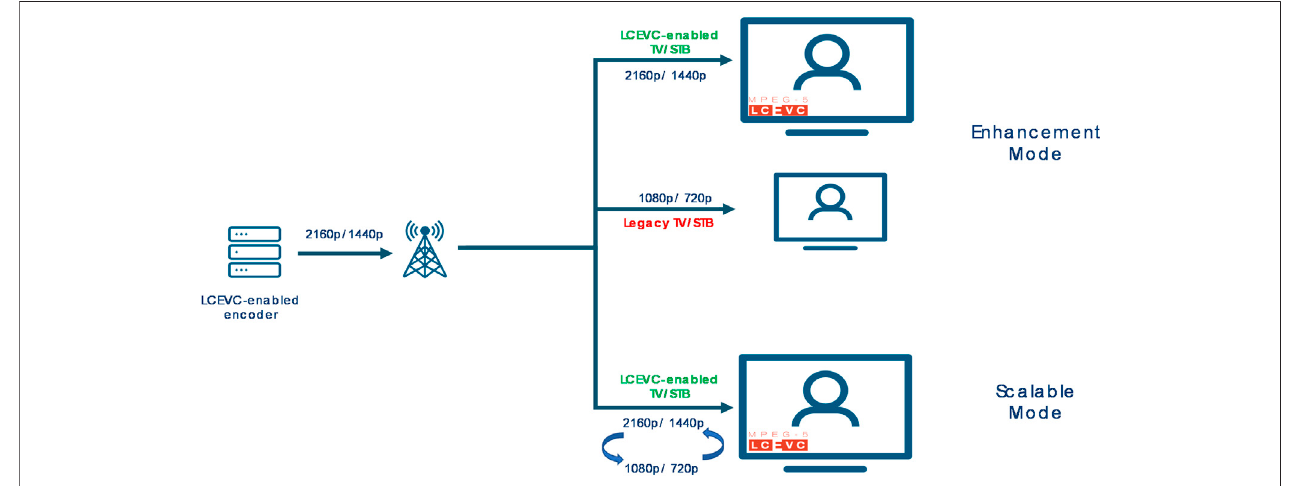
FIGURE 5 | Two of the typical deployment modes for LCEVC